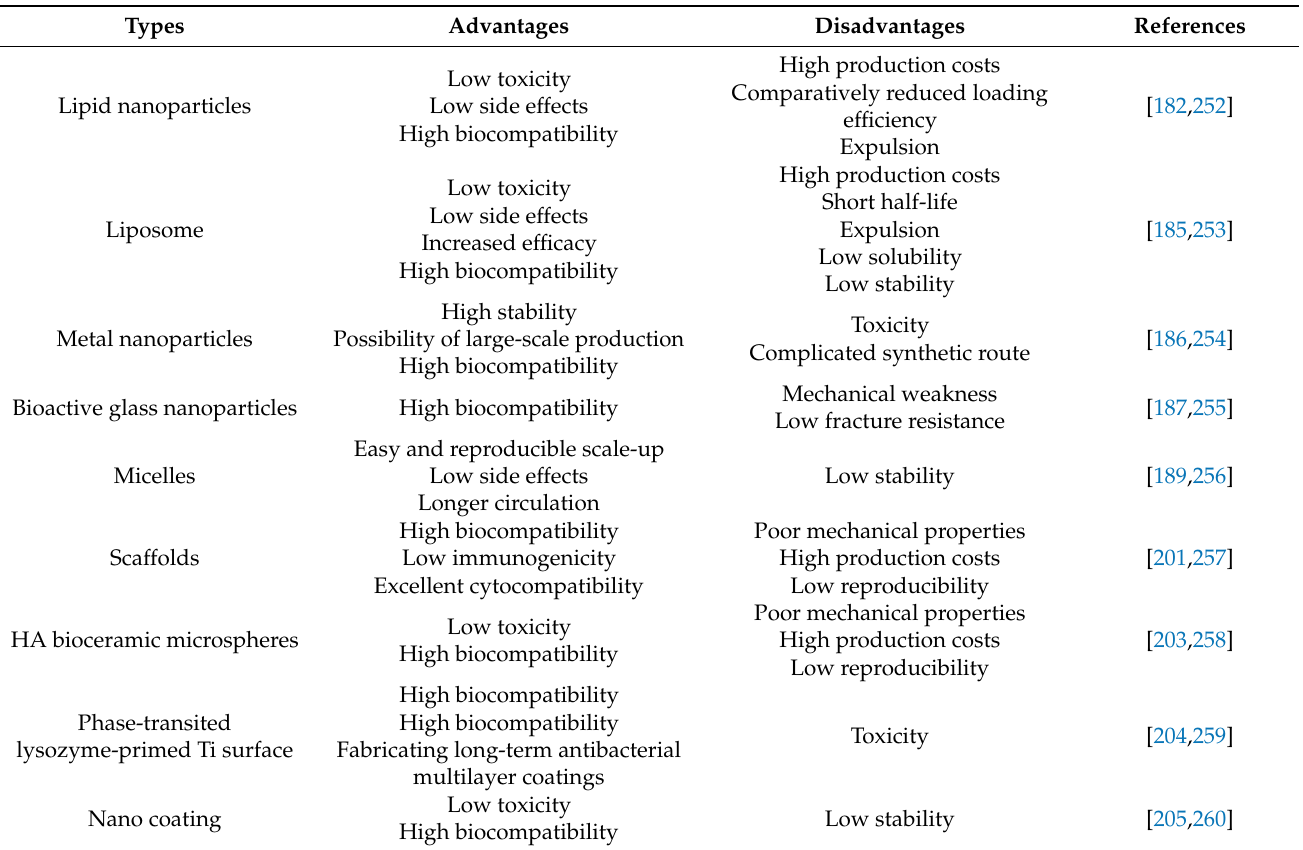
Table 3. Advantages and Disadvantages of delivery systems for